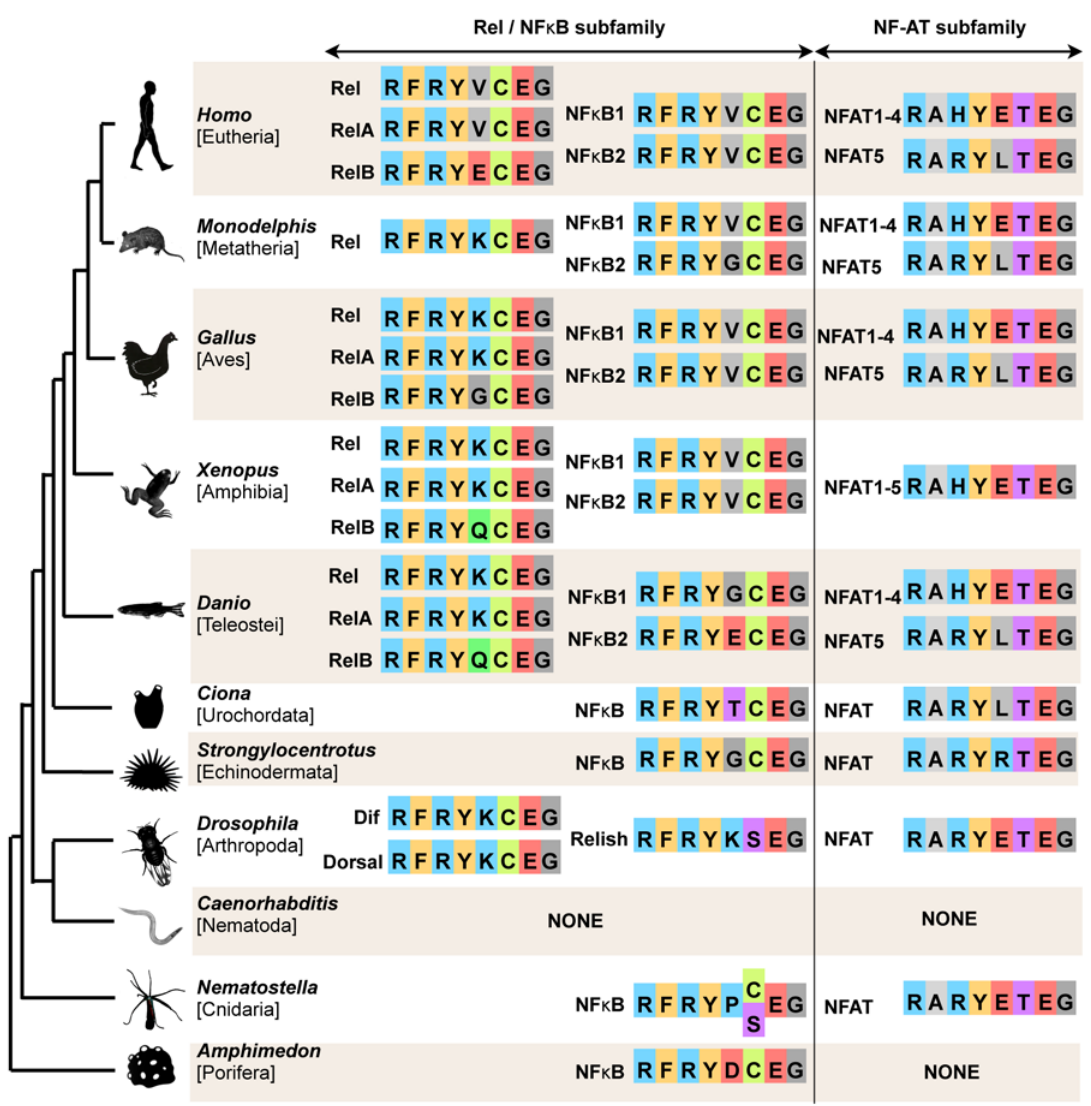
Figure 1. Phylogenetic relationships among major metazoan lineages and sequence of the DNA recognition loop in Rel Homology Domain proteins. The phylogeny depicts the evolutionary relationships among taxa whose genomes have been sequenced. Multiple RHD proteins are encoded in the genomes of all of these animals except the nematode Caenorhabditis elegans , which appears to lack RHD proteins entirely, and the sponge, Amphimedon queenslandica , which appears to possess only a single RHD protein with similarity to NF- k B. The amino acid sequence of the DNA recognition loop is shown for every known RHD protein in these animals.